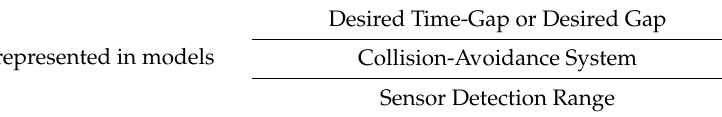
Table 1. The main features of autonomous vehicles that need to be represented in models.